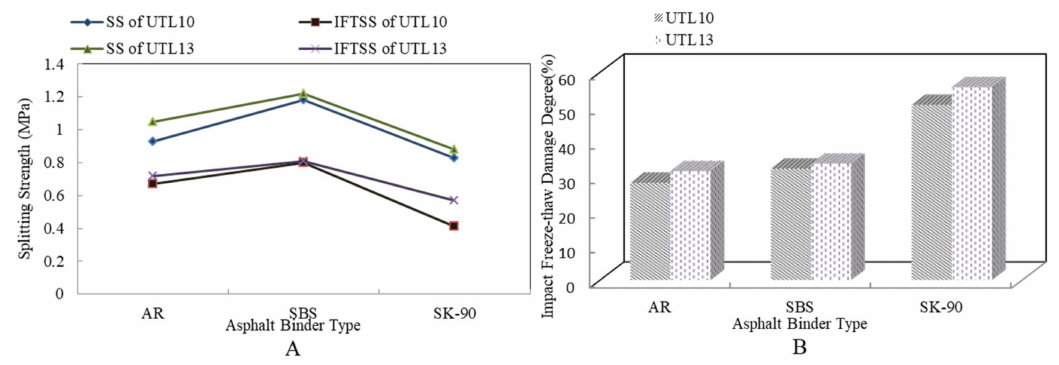
Figure 6. Results of impact freeze-thawing spilt test with di ff erent asphalt binders: ( A ) SS and IFTSS; ( B )